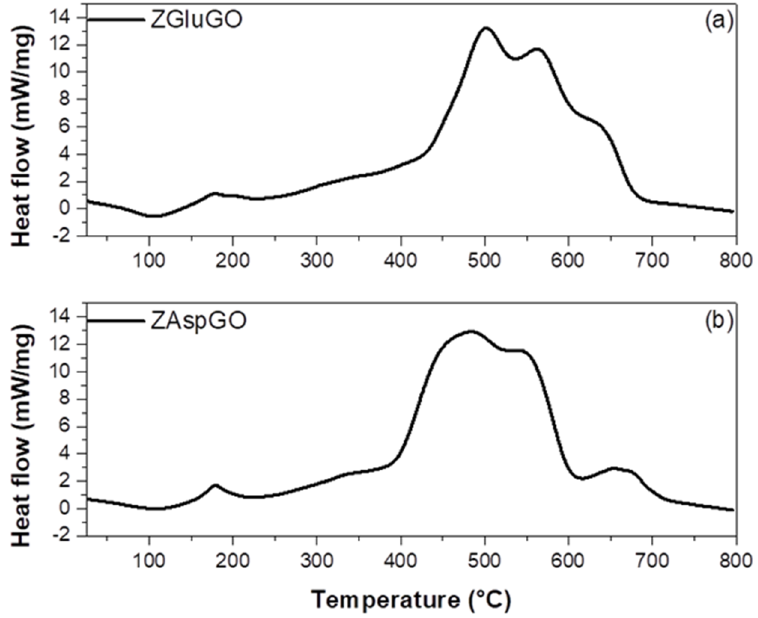
Figure 4. The differential scanning calorimetry plots of ( a ) ZgluGO and ( b ) ZaspGO samples. The FTIR spectra were measured for the amino acids aspartic acid and glutamic acid, and the adsorbent materials ZgluGO and ZAspGO, before and after adsorbing the fluoride ion (Figure 5). The spectra obtained for the amino acids concur with the signals reported in the literature [48,49].